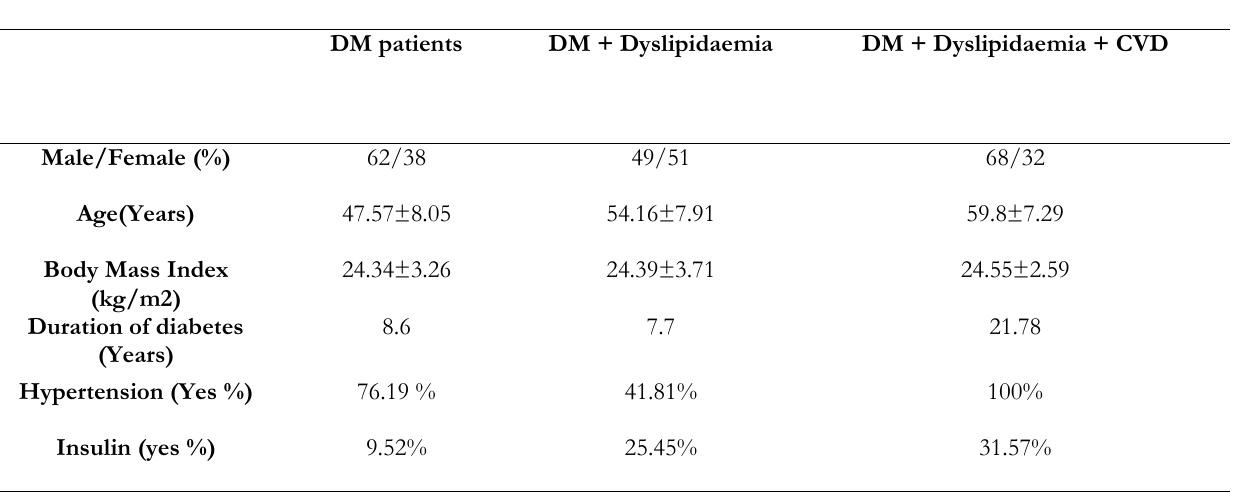
Table 1: Baseline patient characteristics